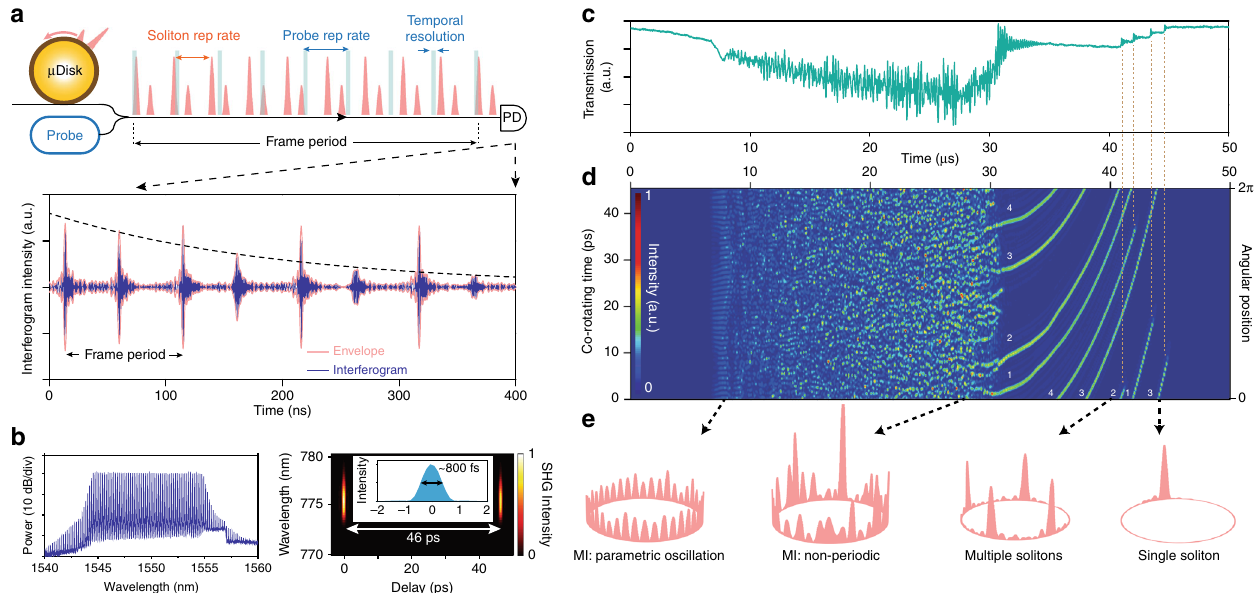
Fig. 1 Coherent sampling of dissipative Kerr soliton dynamics. a Conceptual schematic showing microcavity signal (red) combined with the probe sampling pulse train (blue) using a bidirectional coupler. The probe pulse train repetition rate is offset slightly from the microcavity signal. It temporally samples the signal upon photo detection to produce an interferogram signal shown in the lower panel. The measured interferogram shows several frame periods during which two solitons appear with one of the solitons experiencing decay. PD: photodetector. b Left panel is the optical spectrum and right panel is the second harmonic generation (SHG) intensity of the probe electro-optic comb measured with FROG (pulse repetition period is shown as 46 ps). An intensity autocorrelation in the inset shows a full-width-at-half-maximum pulse width of 800 fs. c Microresonator pump power transmission when the pump laser frequency scans from higher to lower frequency. Multiple steps indicate the formation of solitons. d Imaging of soliton formation corresponding to the scan in c . The x -axis is time and the y -axis is time in a frame that rotates with the solitons (full scale is one round-trip time). The right vertical axis is scaled in radians around the microcavity. Four soliton trajectories are labeled and fold-back into the cavity coordinate system. The color bar gives their signal intensity. e Soliton intensity patterns measured at four moments in time are projected onto the microcavity coordinate frame. The patterns correspond to initial parametric oscillation 51 in the modulation instability (MI) regime 3, 4 , non-periodic behavior (MI regime), four soliton and single soliton states 4,